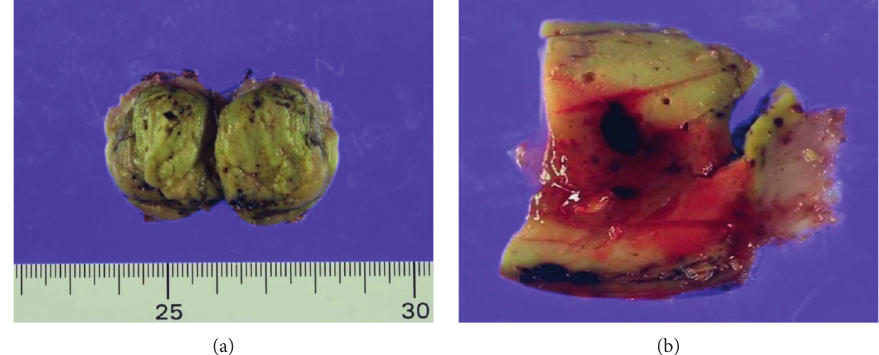
Figure 2: Macroscopic findings. (a) Greenish and soft tumour that measured 30 × 30 × 25mm in size. (b) The tumour was haemorrhagic solid.